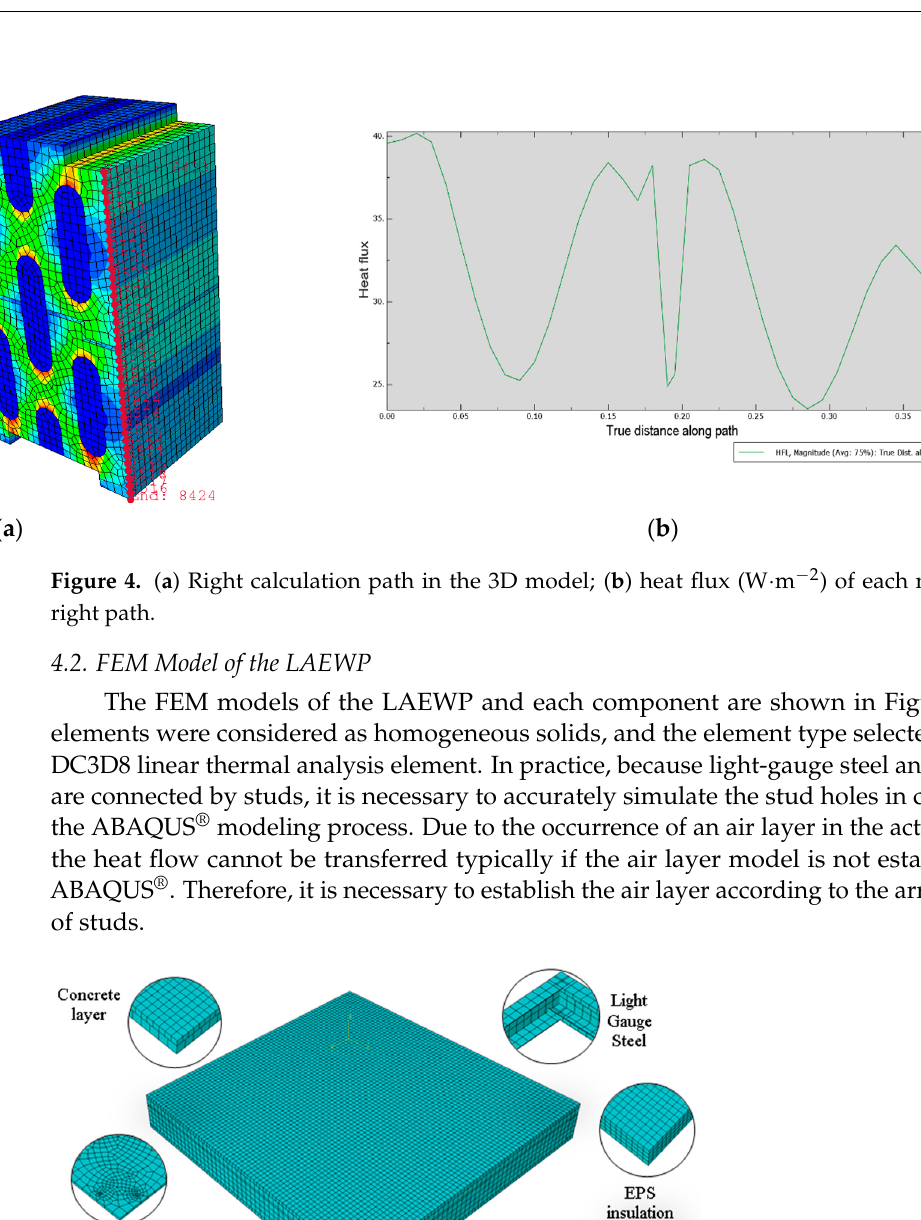
Table 5. Thermal property of different materials of the LAEWP. Items